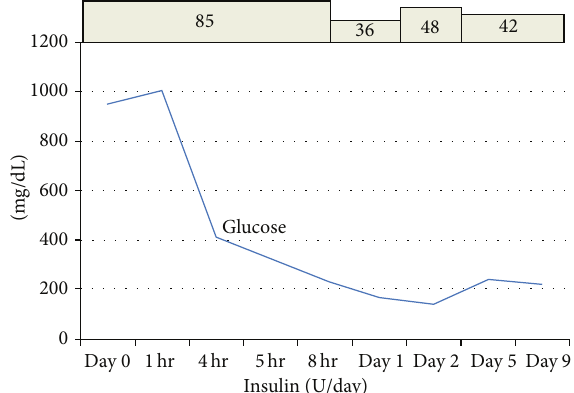
Figure 1: The variations in the blood glucose levels after